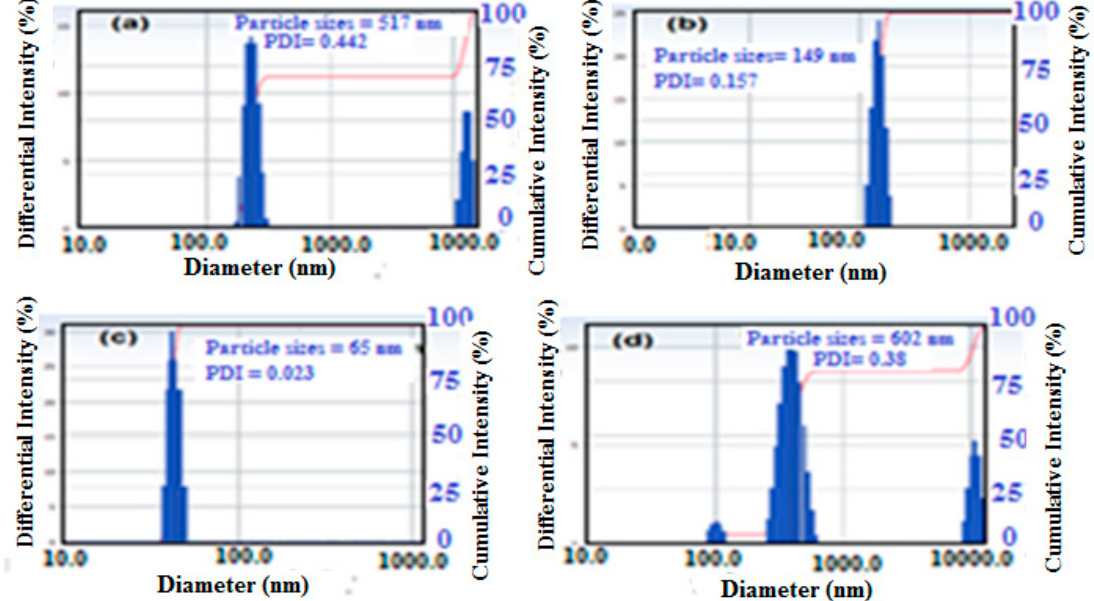
Figure 2. Dynamic light scattering (DLS) data of the hydrophobic SNPs. ( a ) Hydrophobic silica nanoparticles (HSNP), ( b ) HOSNP, ( c ) Emulsified silica NPs (EOSNP1), and ( d ) EOSNP2 in n-hexane, at 25 °C.